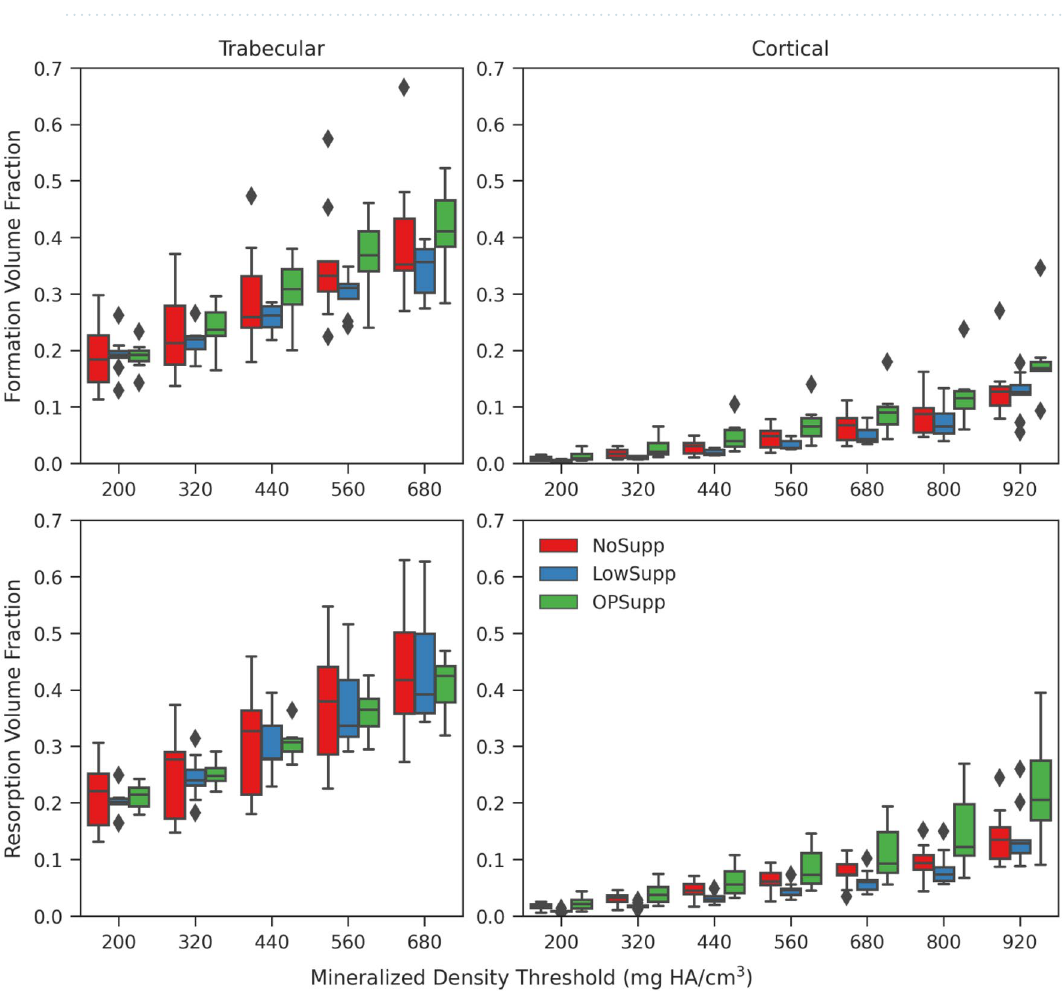
Table 3. ANCOVA summary for static morphometric parameters. p values represent contrast differences as assessed by Tukey’s HSD method. BMD, bone mineral density; BV/TV, bone volume fraction; Tb, trabecular; N, number; Sp, separation; Th, thickness; Ct, cortical; Po, porosity; Po.Dm, cortical pore diameter.